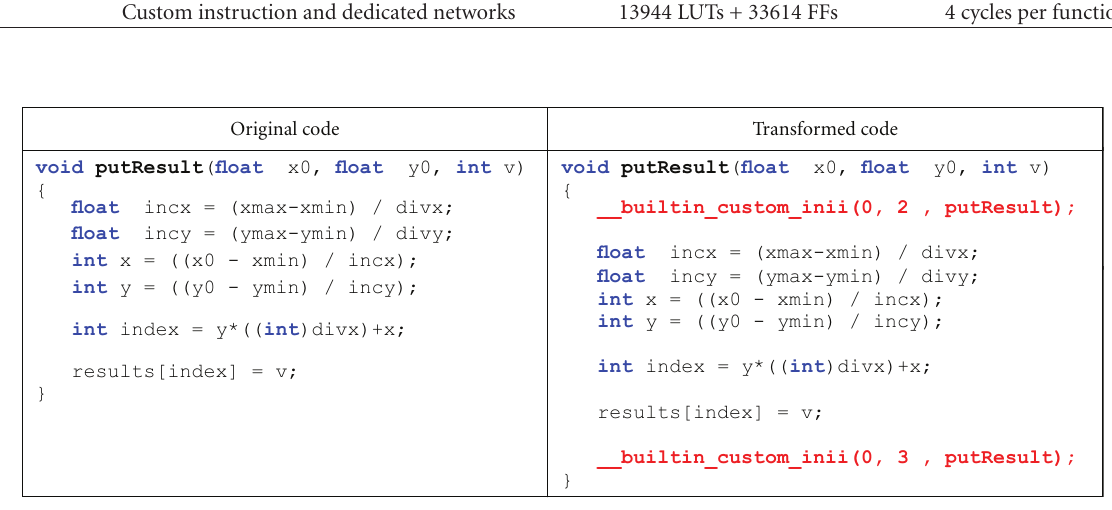
Figure 18: Example of the transformation performed by the source to source compilation phase. The left code is the code before the trans- formation, and the right code is the result of the transformation phase. Notice how the custom instructions have been inserted